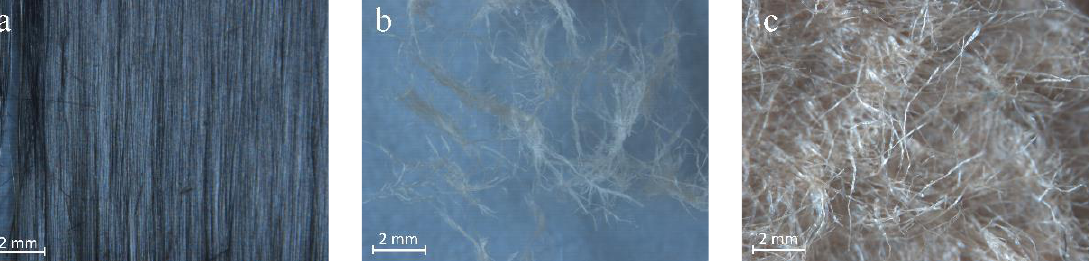
Figure 1. Images (zoomed in 25 times) of CF ( a ), shorter cellulose fiber ( b ) and “hand fan” cellulose fiber ( c ).